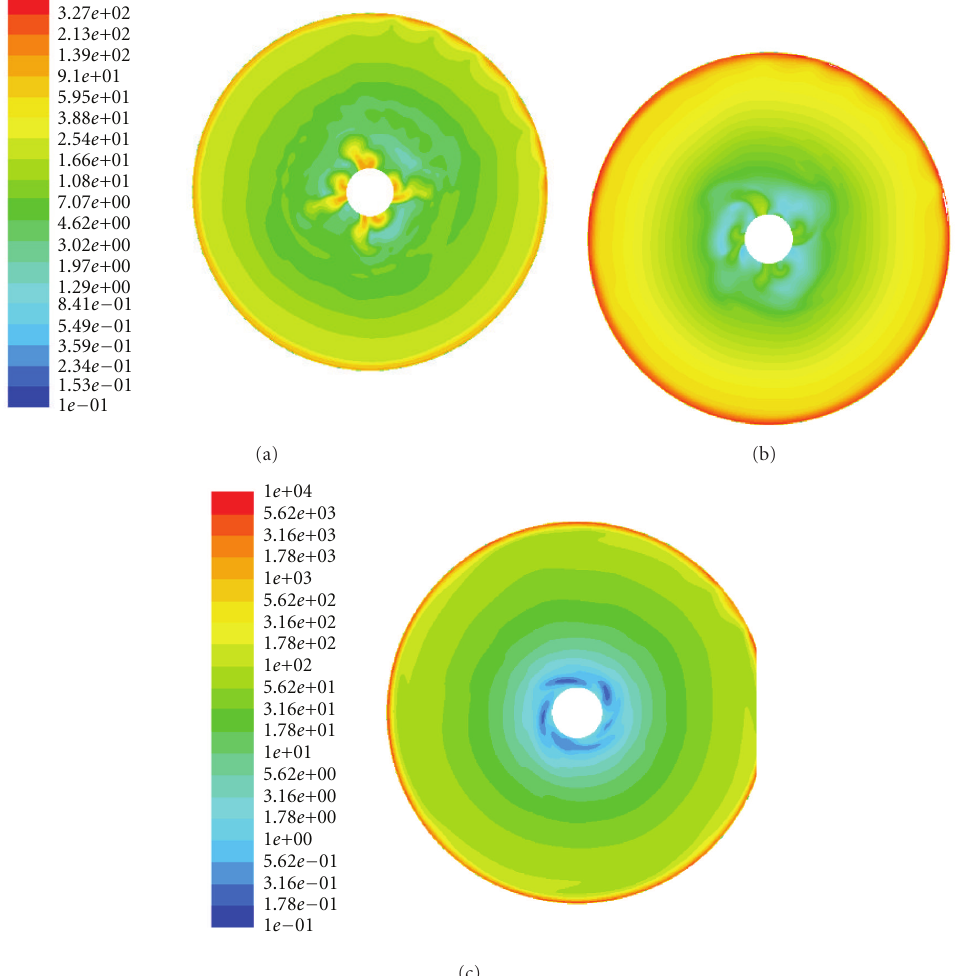
Figure 5: Contour plot of turbulent dissipation rate ( ε ) outer region ( r = 0 . 01m to r = 0 . 075 m) [ D = 0 . 2m] [ z = 0 . 00075 m]. Flow rate: 300mL/min, (a) 600 rpm, (b) 1000 rpm, and (c) 1400